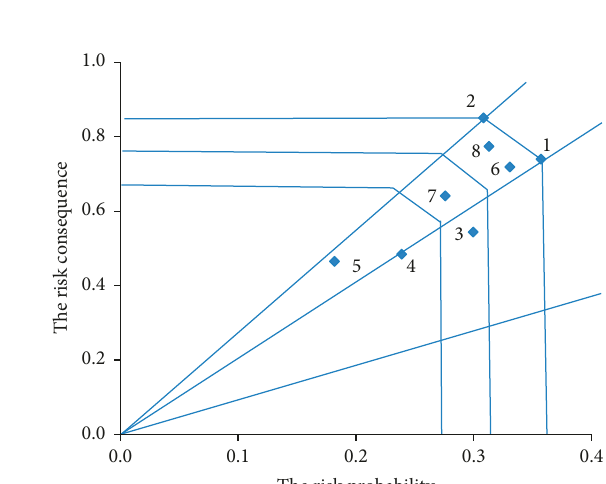
Figure 6: Fault tree analysis of trampling accidents.